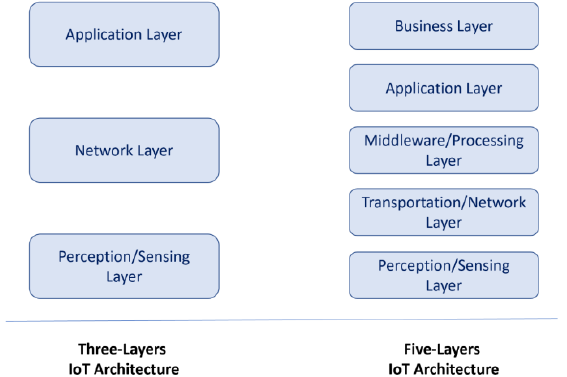
Figure 1. The most common IoT architectures (three-layer and five-layer) retrieved from the litera-